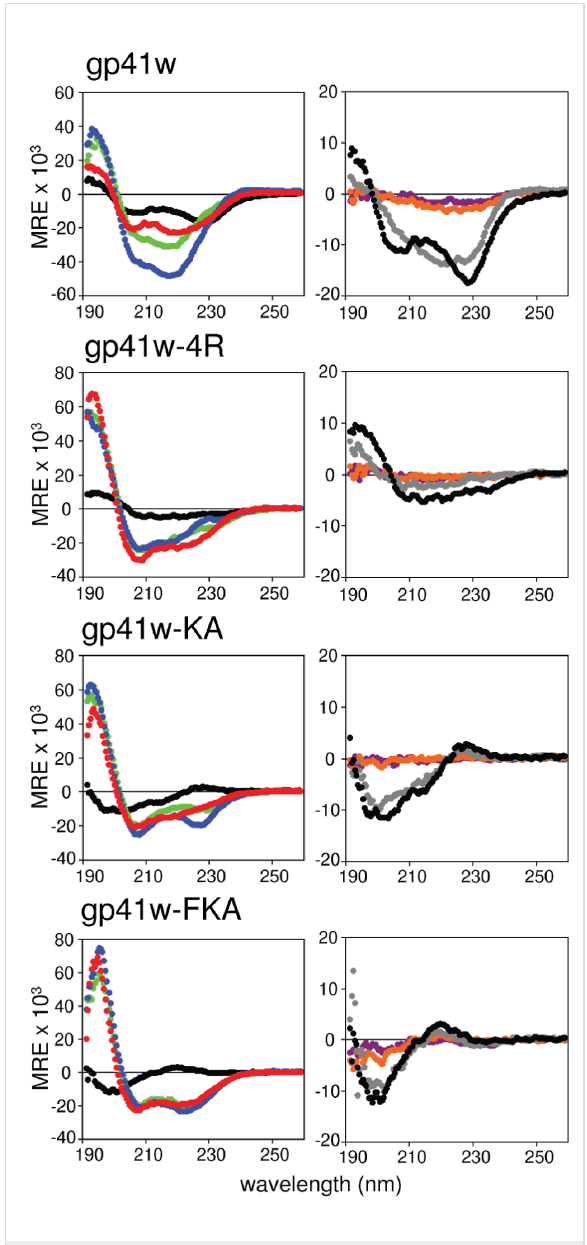
Figure 6: Far-UV CD spectra of gp41w and the three derivative peptides. The panel on the left shows the peptides in phosphate buffer (black), 25 mM SDS (green), 25 mM DPC (yellow) and 50% TFE (red). The panel on the right is the peptides in the presence of LUVs composed of ePC:ePG (violet), ePE:ePG (orange) or ePC:ePE (gray). All data are reported in units of mean residue ellipticity (MRE) with units of deg cm 2 dmol − 1 res − 1